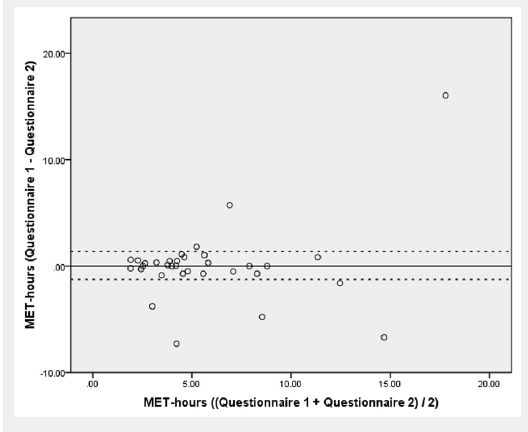
Bland-Altman plot of questionnaire 1 minus questionnaire 2 (vertical axis) against mean of questionnaire 1 and questionnaire 2 measured in MET-hours (horizontal axis). The solid horizontal line corresponds to the mean difference (0.06 MET-hours) while the dashed horizontal lines correspond to the 95% confidence interval (–1.26 to 1.37 MET-hours) (n = 33).